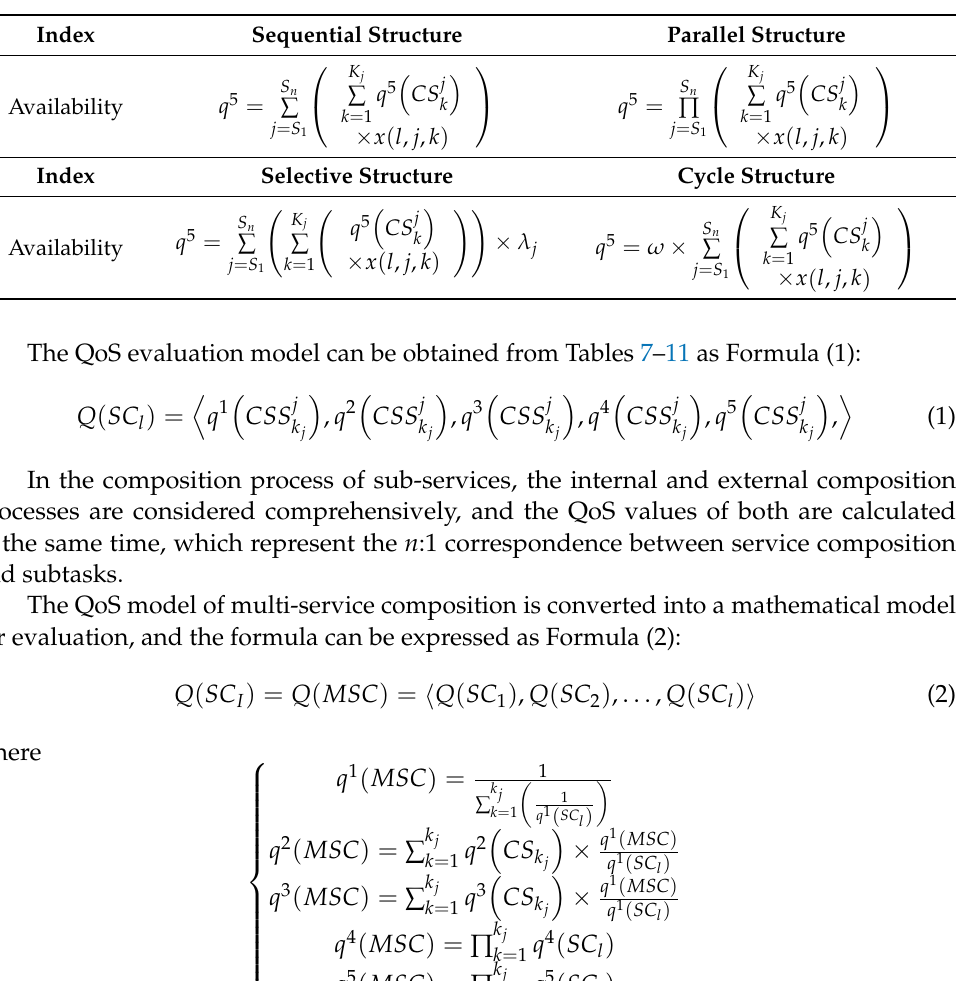
Table 11. QoS expressions of internal composite